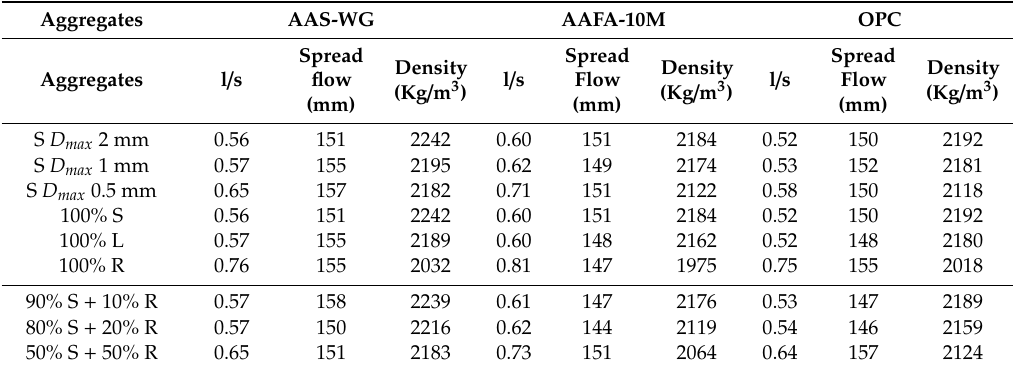
Table 6. Fresh state liquid / solid (l / s), spread flow, and density for alkali-activated material (AAM) and OPC mortars with an aggregate / binder ratio of 2 /